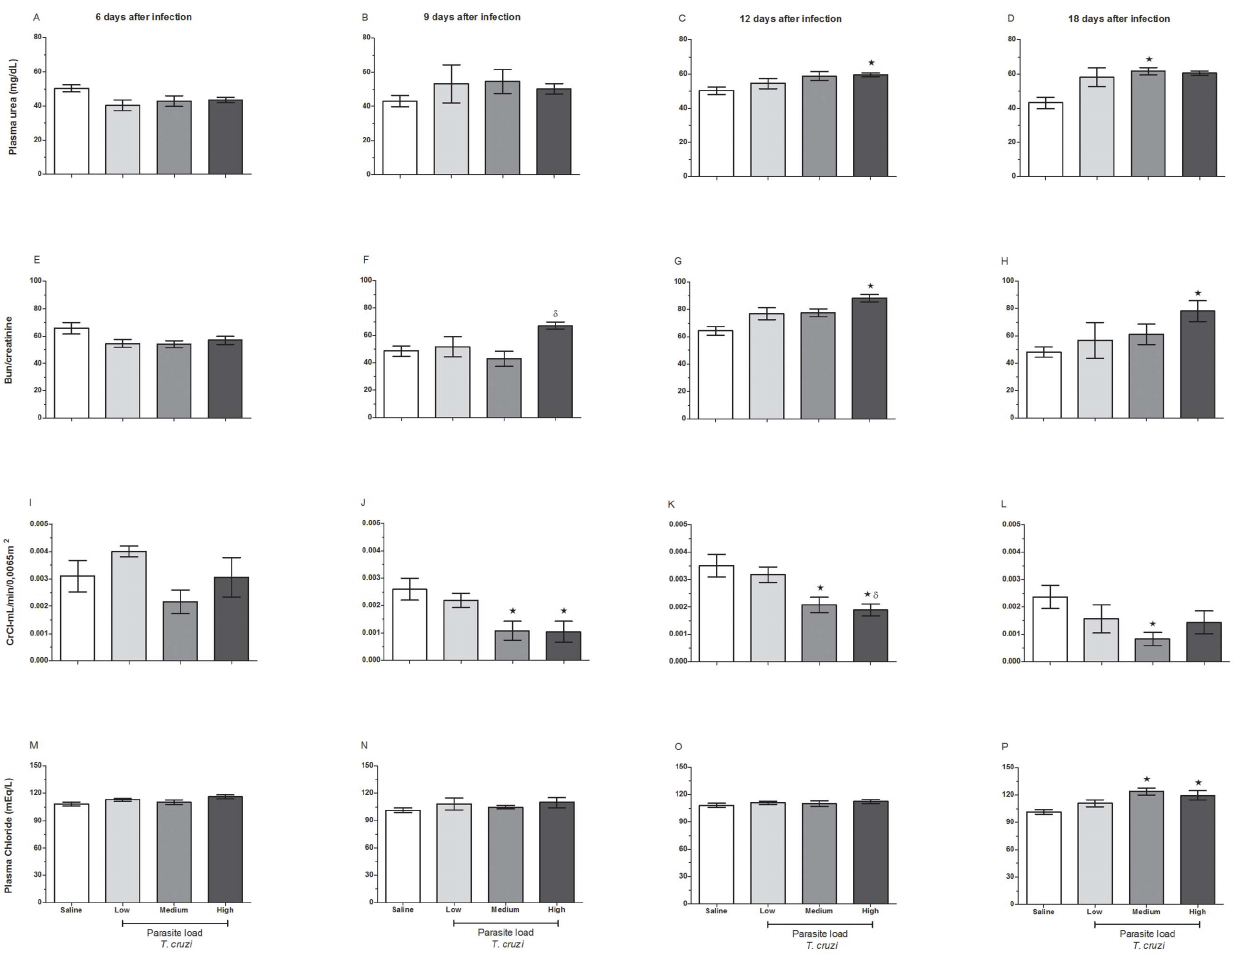
Figure 3. Effect of T.cruzi parasite loads on plasma urea concentration, BUN/creatinine ratio, creatinine clearance and plasma chloride ion levels. C57BL/6 mice were challenged with 3 6 10 2 (low dose), 3 6 10 3 (medium dose) or 3 6 10 4 (high dose) blood trypomastigotes, and 6, 9, 12 and 18 days post-infection, the plasma and urine (24 hours) of these animals were collected. The plasma urea (A–D) and creatinine levels were measured, and the ratios between blood urea nitrogen (BUN) and creatinine (E–H) were calculated. To determine the creatinine clearance, the urine creatinine levels were measured over a 24-hour period (I–L). The concentration of chloride ions (mEq/L) was measured in the plasma from the same mice (M–P). We used commercial kits for these analyses, as described in Materials and Methods. Each bar represents the mean 6 standard deviation of individual values from 10 mice. *p # 0.05 indicates a significant difference when animals from the highly infected group were compared to the uninfected control